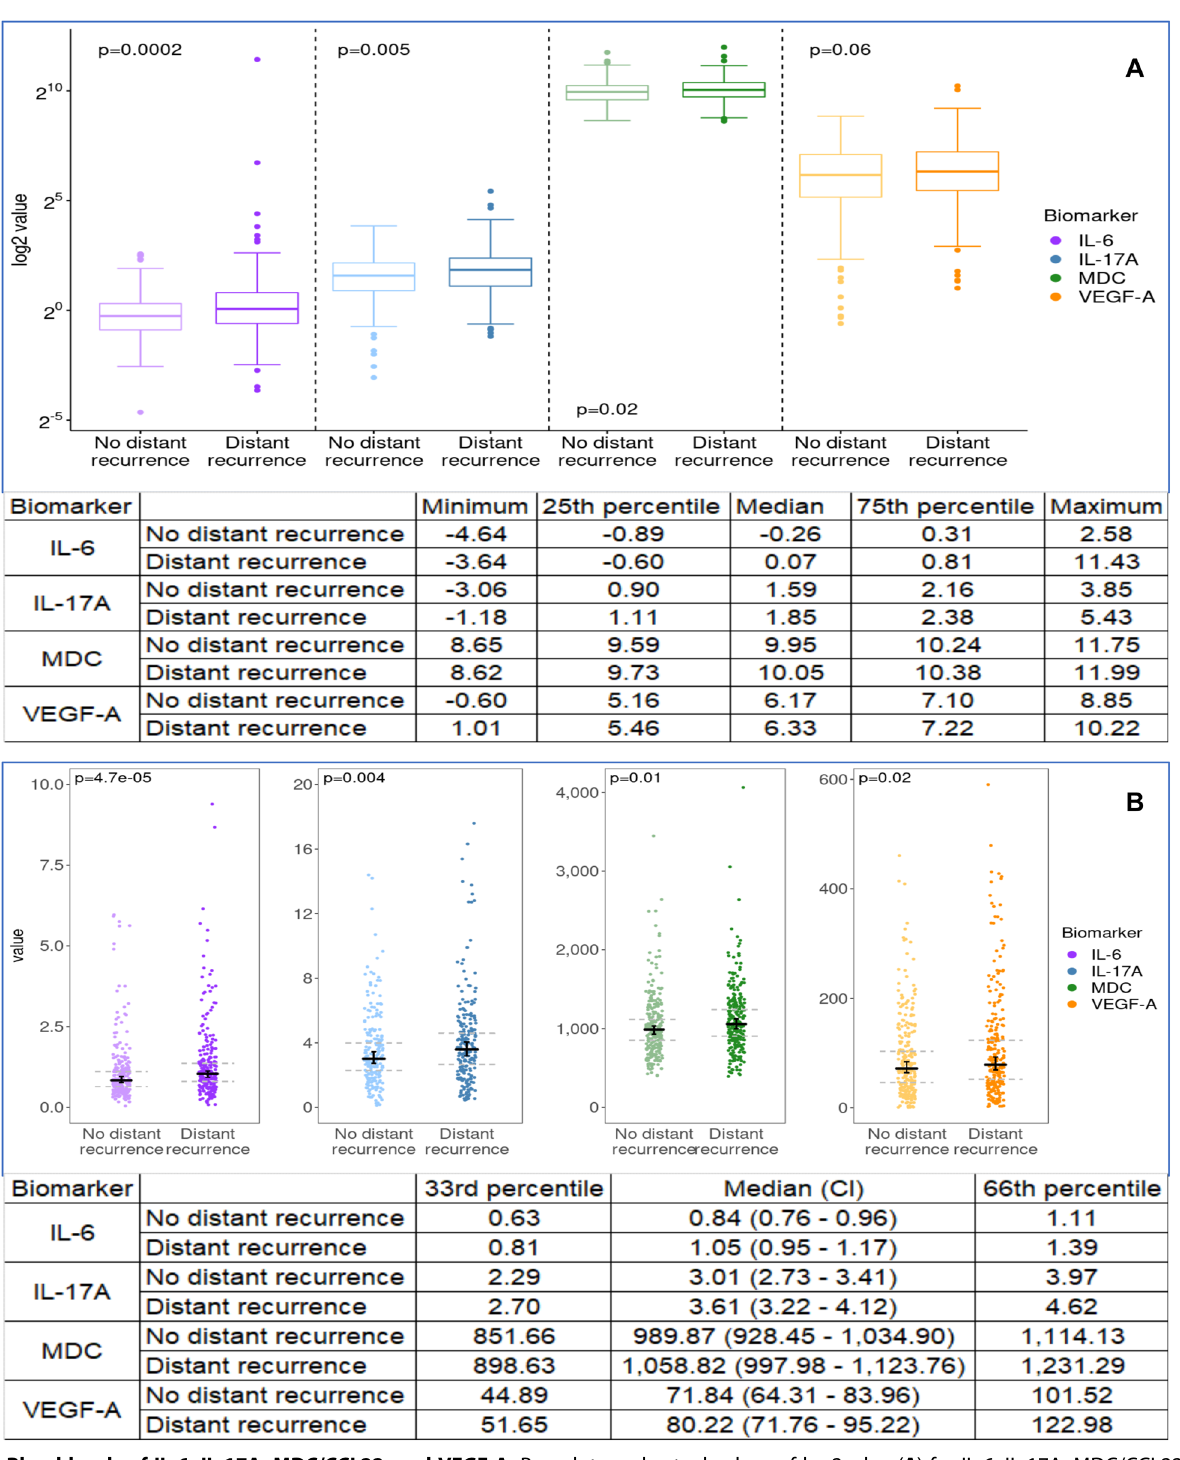
extracellular bacteria and fungi 14 . Several monoclonal antibodies that inhibit the function of IL-17A have been approved for psoriasis and psoriatic arthritis (secukinumab, ixekizumab, brodulmab) 15 . Evidence indicates that IL-17A may also have a role in promoting metastasis by eliciting expansion and polarization of neutrophils that suppress